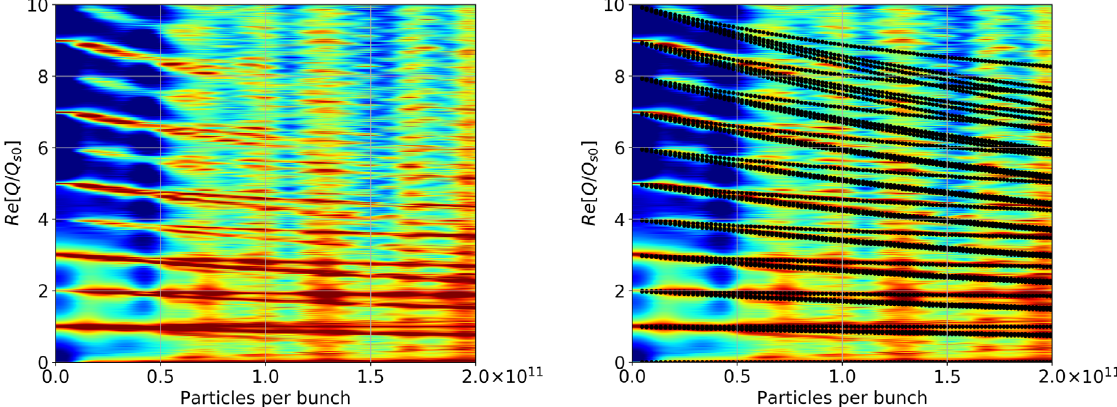
FIG. 11. Comparisons of the real part of the normalized mode-frequency shift between SBSC code and GALACLIC (black dots in the right-hand side) with the pure inductive impedance.